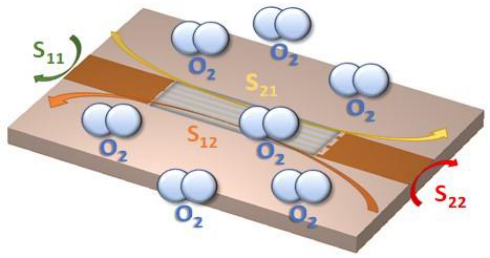
Figure 2. Illustration of the experimental characterization of the developed sensor for oxygen sensing.